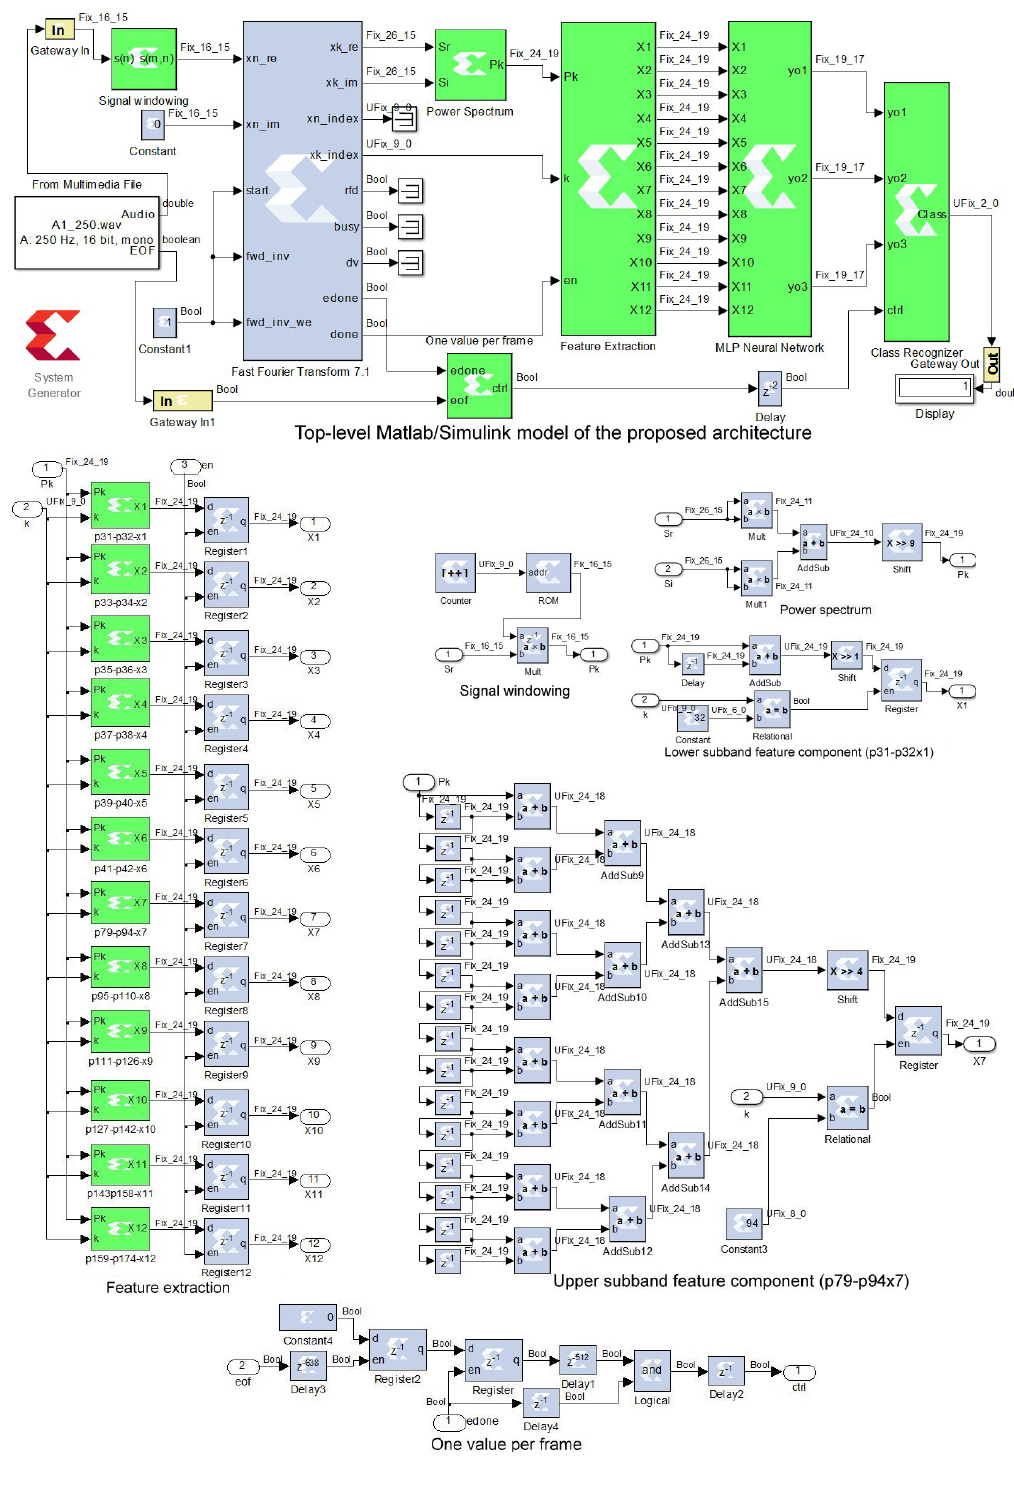
Figure 5. Implementation of the proposed classification technique on field programmable gate array (FPGA) using Xilinx System Generator (XSG). The top-level Simulink diagram (top panel) with details of different subsystems (bottom panels). The green blocks are designed using the XSG blocks (blue). The white blocks are the standard Simulink